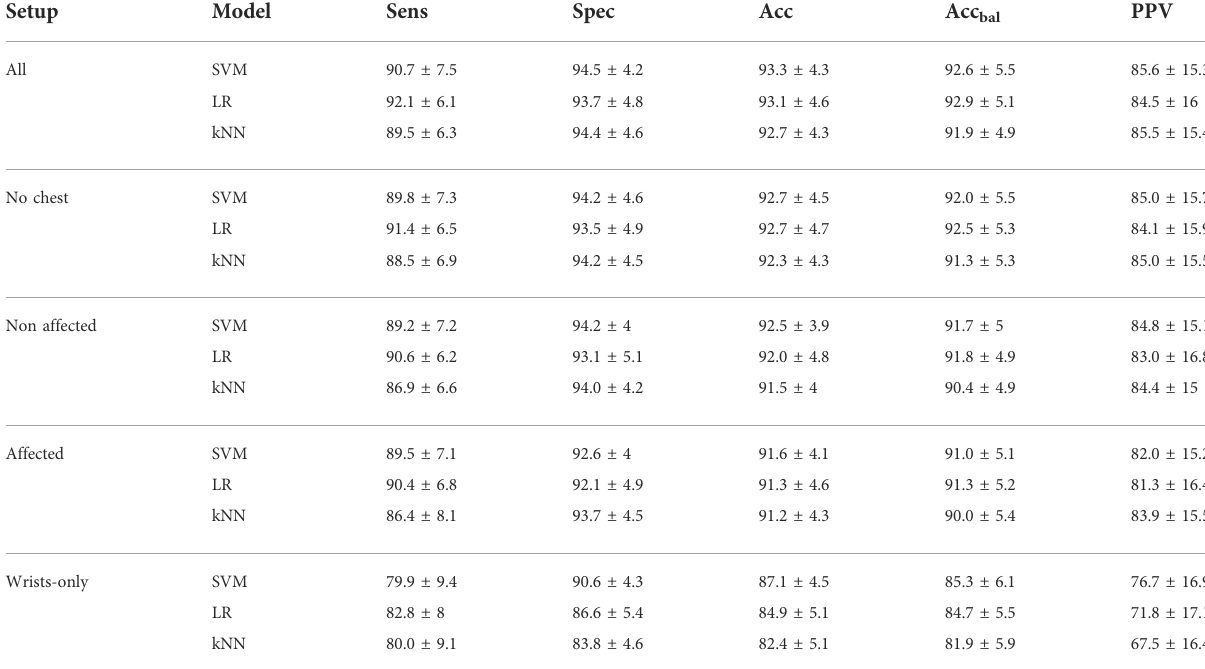
TABLE 4 Model performance for gait classi fi cation across sensor con fi gurations (setup). Setup